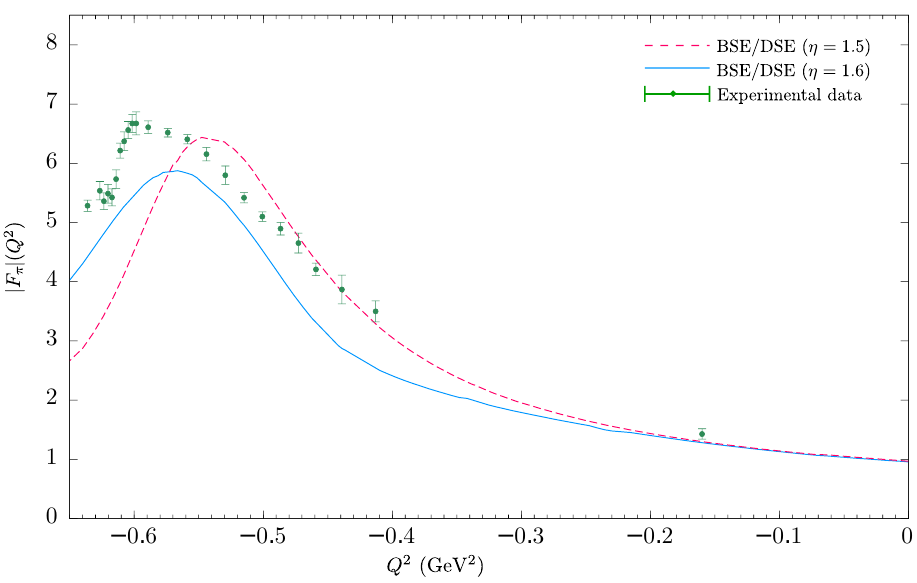
Table 1. The pion mass m π , the pion decay constant f π , the ρ -meson and ω -meson masses m ρ and m ω Figure 6. Absolute value of the pion form factor in the time-like Q 2 < 0 domain for the model param- for the two di ff erent used parameterisations of the model (labeled with η ) and for the case with gluon- eters η = 1 . 5 and η = 1 . 6 as described in the text and compared to experimental data [14]. and pion-exchange kernels but without decay kernels are shown. The current quark mass has been set to m q = 6 . 8 MeV. The two rightmost, separated, columns display for the case when including the = M 2 iM ρ Γ ρ . All values for decay kernels the extracted ρ -meson pole position defined as M 2 ρ − pole dimensionful quantities are given in GeV.